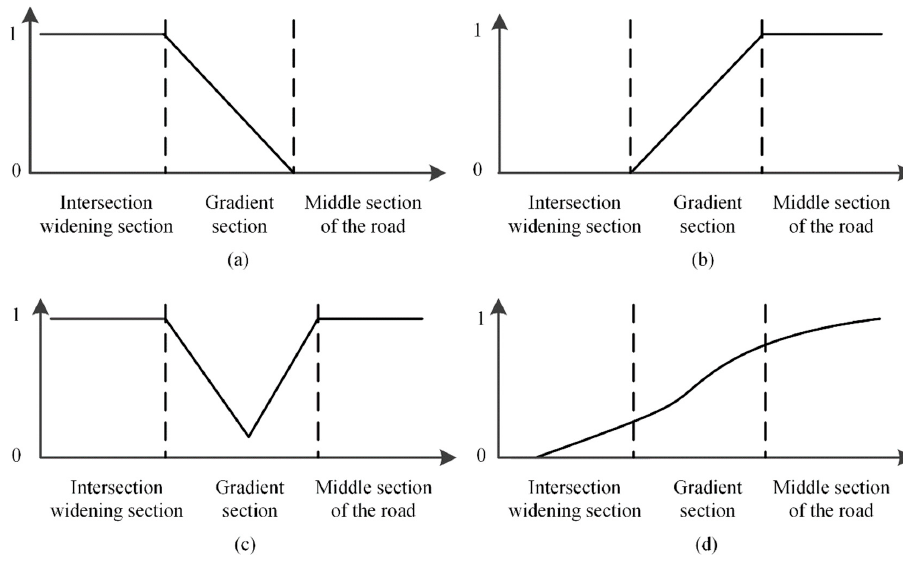
Figure 4. FCD Eigenvector normalized value ( a ) coverage width ( b ) density ( c ) direction ( d ) speed.